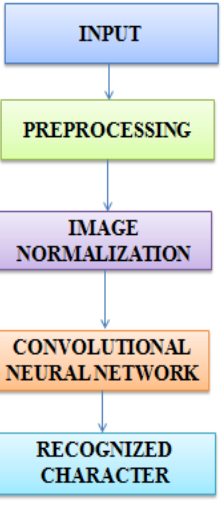
Figure 4. Preprocessing of the model